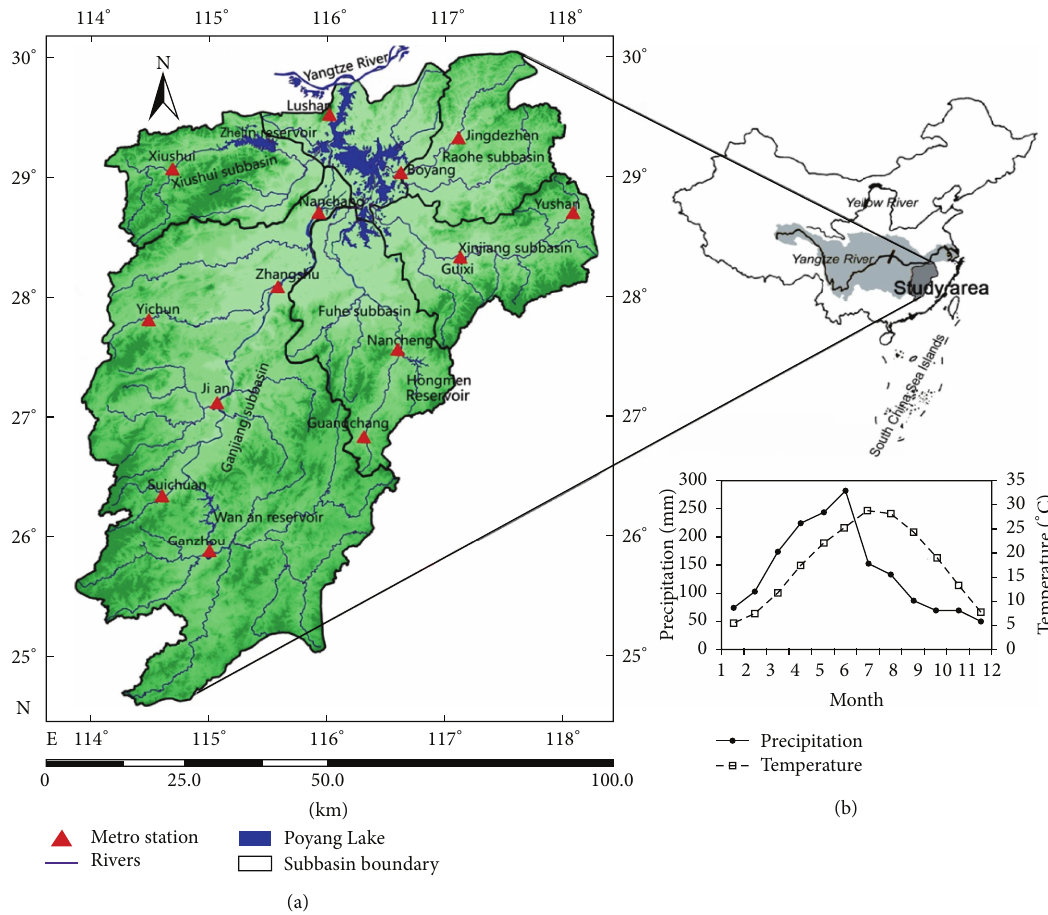
Figure 1: The geophysical location of Poyang Lake, China. (a) Distribution of meteorological stations across the Poyang Lake catchment, and (b) mean monthly precipitation and temperature of the Poyang Lake catchment for the period